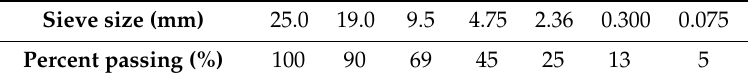
Table 2. Selected aggregate